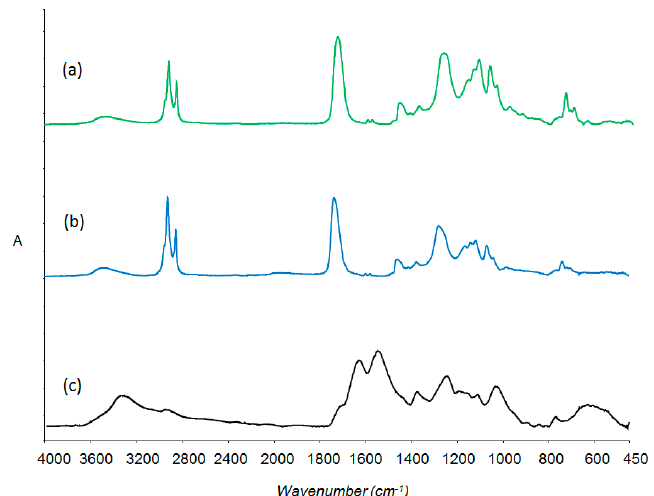
Figure 7. Infrared spectra of: ( a ) Neat alkyd; ( b ) Extracted core; and ( c ) PMUF shell.